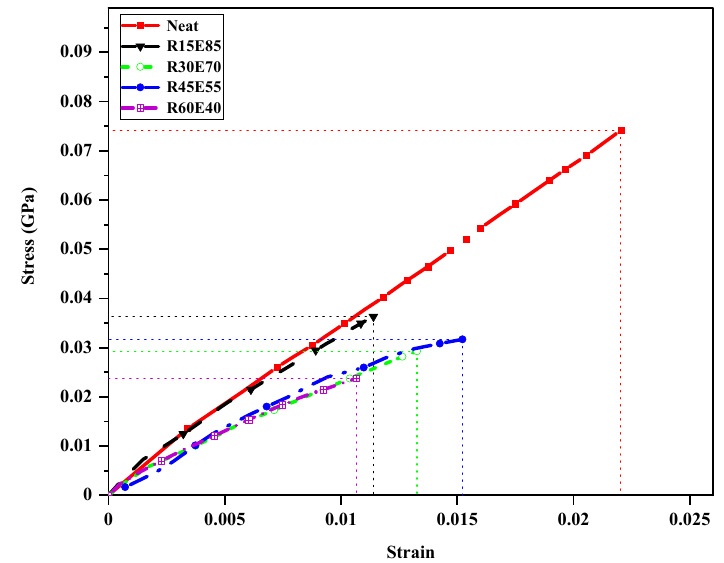
Figure 11. Stress–strain plot of test samples under a flexural load.